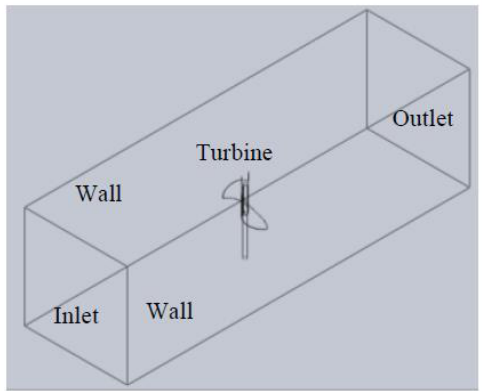
Figure 8. A position angle θ of the turbine’s two blades.